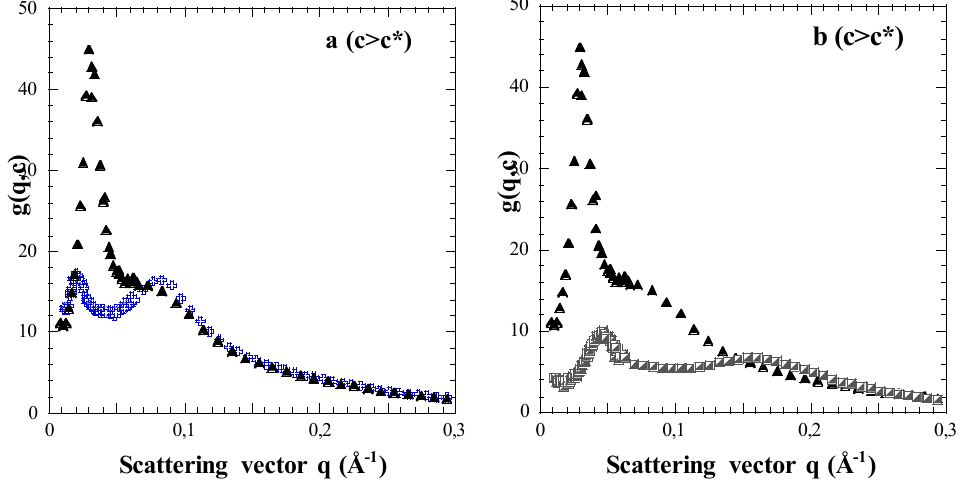
Figure 2. Scattering functions of NaPSS star solutions in the semi-dilute regime. ( a ) Changes according to N a ; S100-S91/D 2 O c = 0.258 mol·L − 1 − φ = 2.87% (dotted triangles); S300-S94/D 2 O c = 0.230 mol·L − 1 – φ = 2.57% (crosses); ( b ) Changes according to c ; S100-S91/D 2 O c = 0.258 mol·L − 1 – φ = 2.87% (dotted triangles); S100-S91/D 2 O c = 0.996 mol·L − 1 – φ = 11.08% (half-dotted squares).